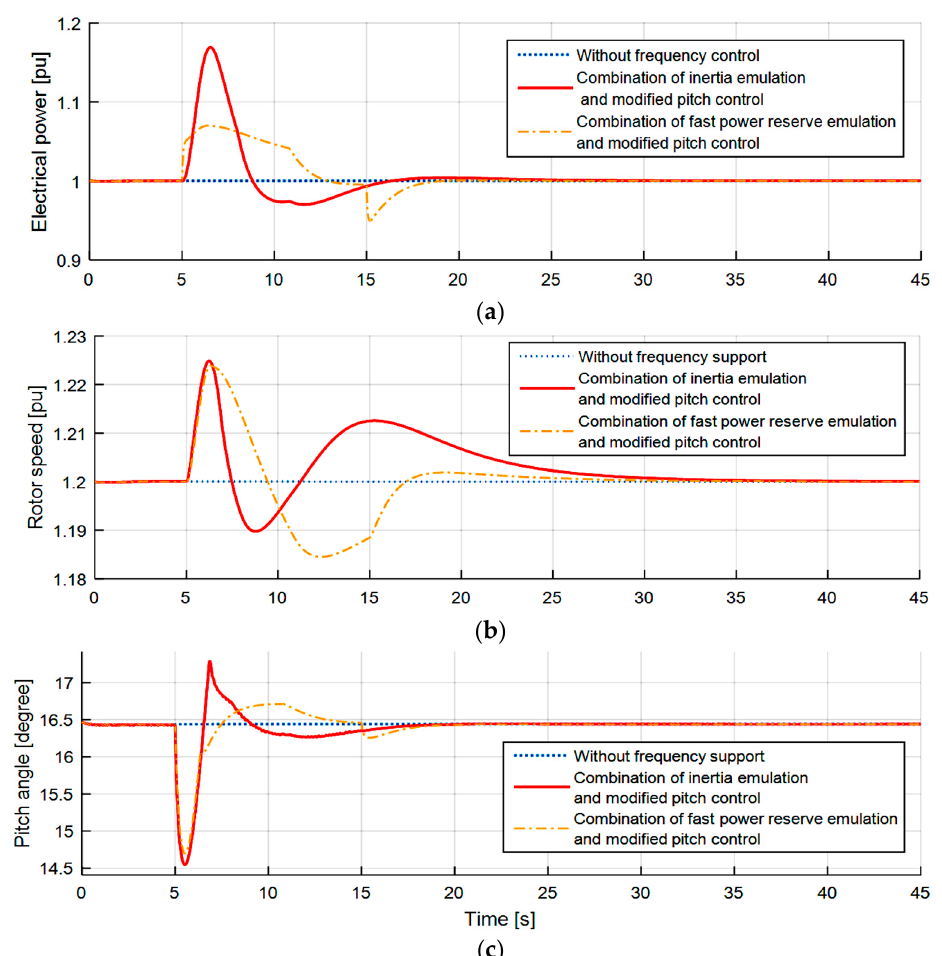
Figure 20. ( a ) Electrical power; ( b ) rotor speed; and ( c ) pitch angle of VSWT in high wind speed case after frequency disturbance.